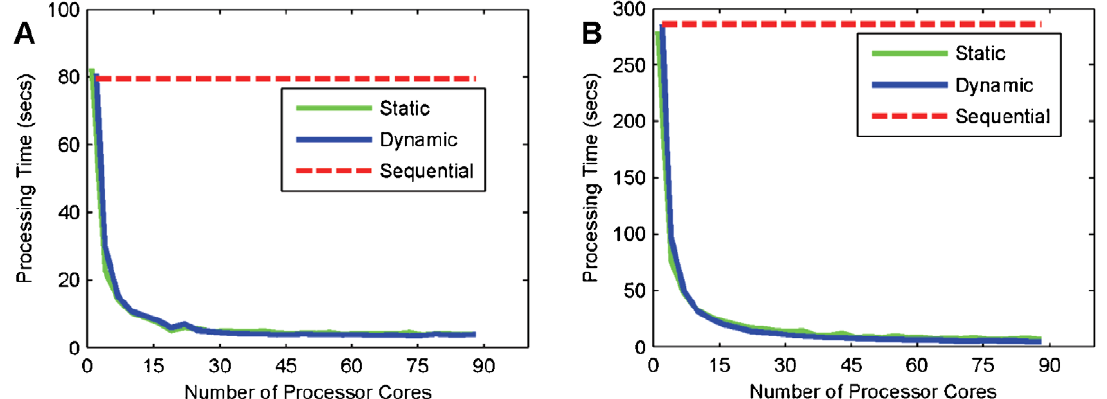
Fig. 5. Comparison of processing time between static load balancing and centralised dynamic load balancing. This comparison was using the calculation of texture features on TMA1 as an example. (A) Loading time, (B) Saving time. (Colours are visible in the online version of the article; http://dx.doi.org/10.3233/ACP-CLO-2010-0551.)